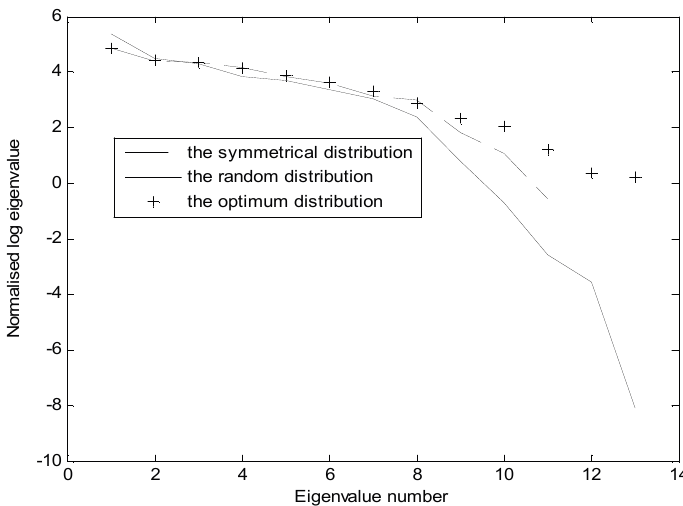
Figure 6. Comparison of eigenvalue